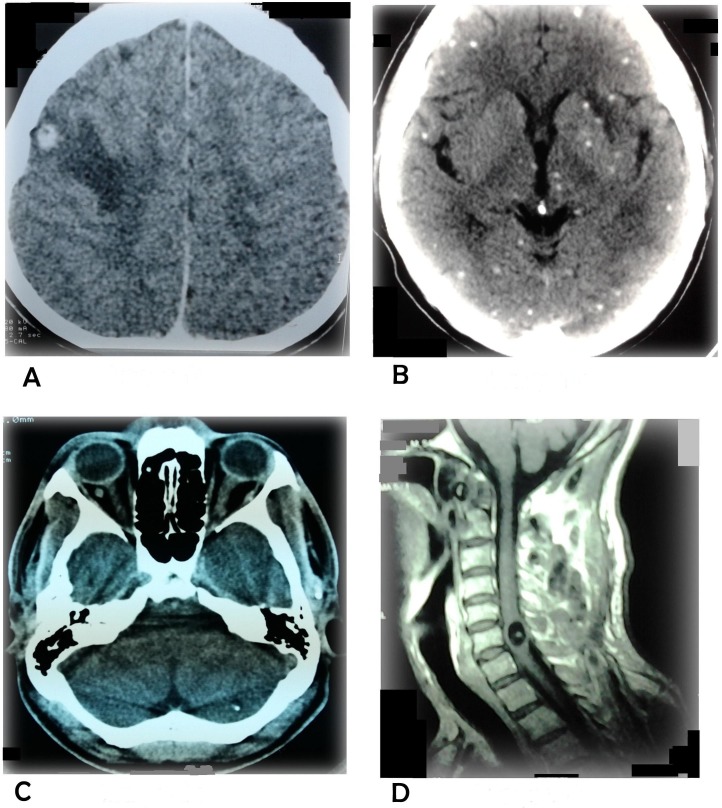
A-Single NCC with peri-lesional edema detected by CT in the right fronto-parietal area. B-Multiple NCC with starry sky pattern. C-Ocular NCC. D-Spinal NCC.